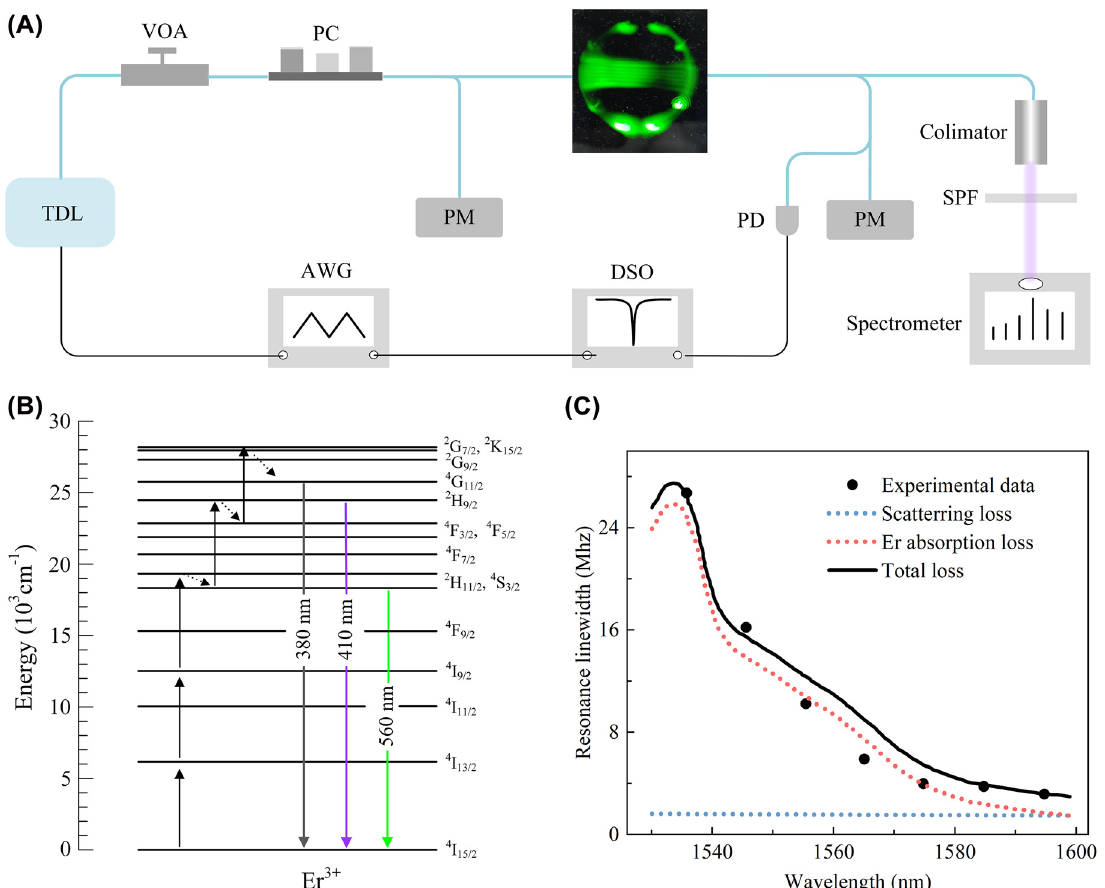
Figure 1: Four- and five-photon upconversion CW lasing at room temperature. (A) Experimental set-up. AWG, arbitrary waveform generator; TDL, tunable diode laser; VOA, variable optical attenuator; PC, polarization controller; PM, power meter; SPF, short-pass filter; PD, photodetector; DSO, digital storage oscilloscope. (B) Energy level diagram and proposed emission mechanisms of four- and five-photon upconversion processes. The dotted arrows represent the NR process. The upward full arrows represent the upward transition induced by the photon excitation and ET processes. (C) Resonance linewidth evolution in a wavelength range covering six FSRs. The black fitting curve represents the total resonance linewidth induced by the absorption loss of the gain materials and the surface scattering loss.